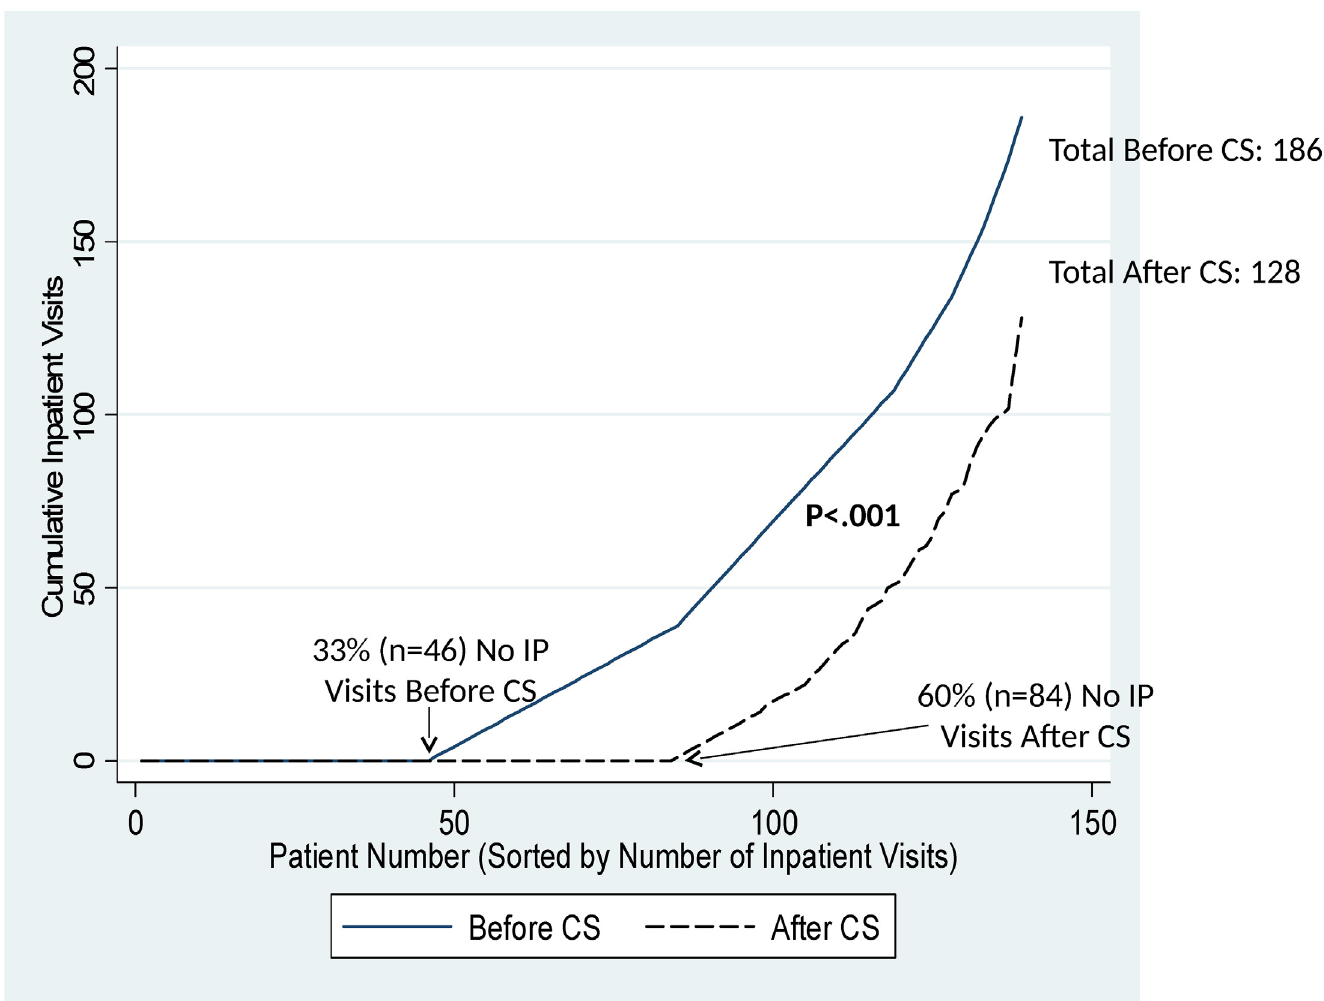
Fig 3. Cumulative Number of Inpatient Visits (IP) Visits in Care Support (CS) Patients Before and After Enrollment. The cumulative number of IP visits is shown as a function of patient number (sorted by number of IP visits) during the 6 months before enrollment in Care Support (solid line) and the 6 months after enrollment (dashed line). The proportion of patients with zero IP visits increased significantly from 33% pre-enrollment to 60% post-enrollment (McNemar ’ s test, p <